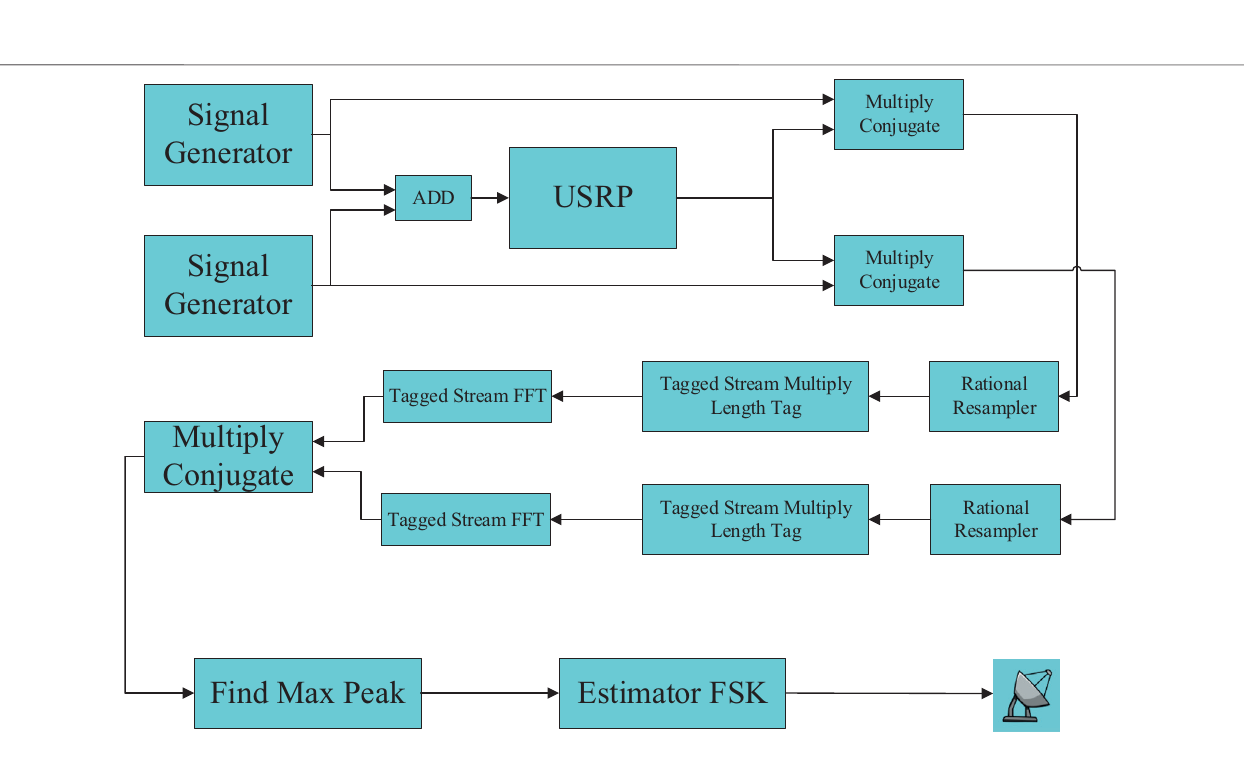
FIGURE 3 | The block diagram of the receiver based on the software de fi ned radio.